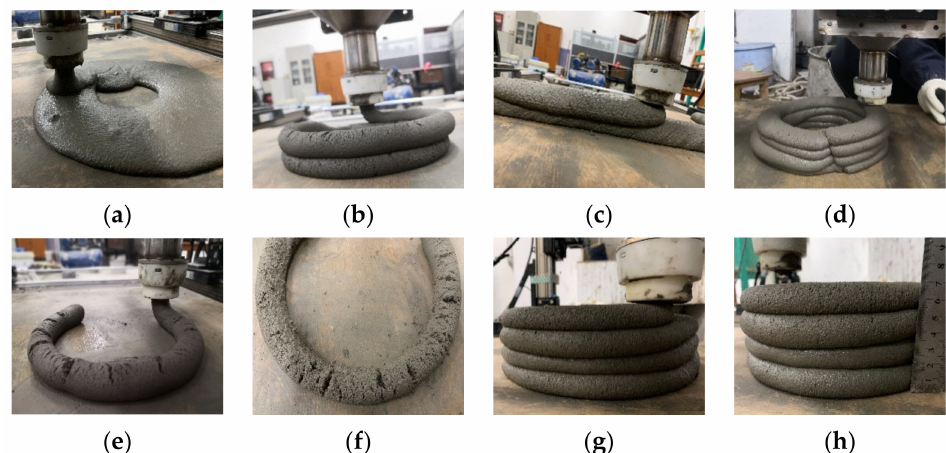
Figure 16. The printed specimens with different dosage of superplasticizer and nano-clay: ( a ) control mix, ( b ) TP-1; ( c ) TP-2, ( d ) NC-1, ( e ) NC-2, ( f ) NC-3, ( g ) M-1 and ( h ) the deformation measurement of M-1